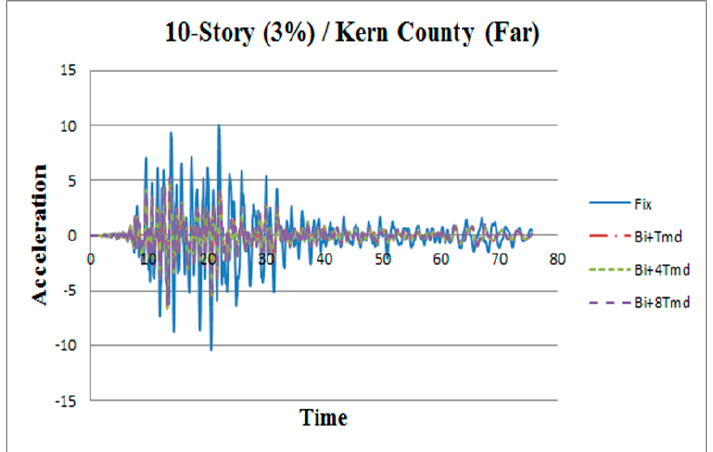
Figure 3. Acceleration time histories for top story of 10-story building under the Loma Prieta (far-fault) earthquake.